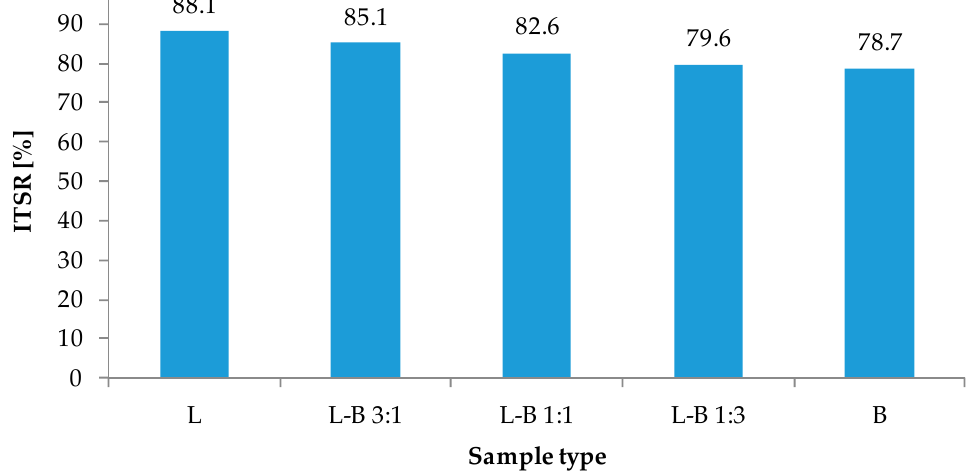
Figure 9. Water and frost resistance of studied mixes measured with indirect tensile strength ratio (ITSR) indicator.